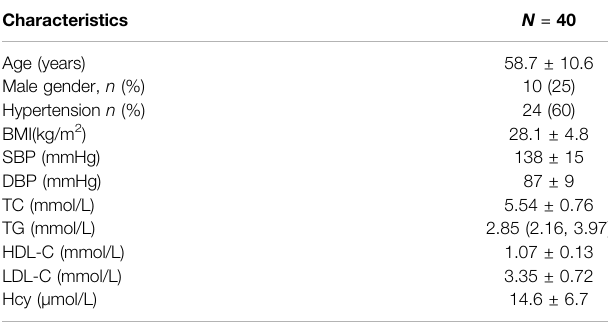
TABLE 1 | Baseline characteristics of Xuezhikang